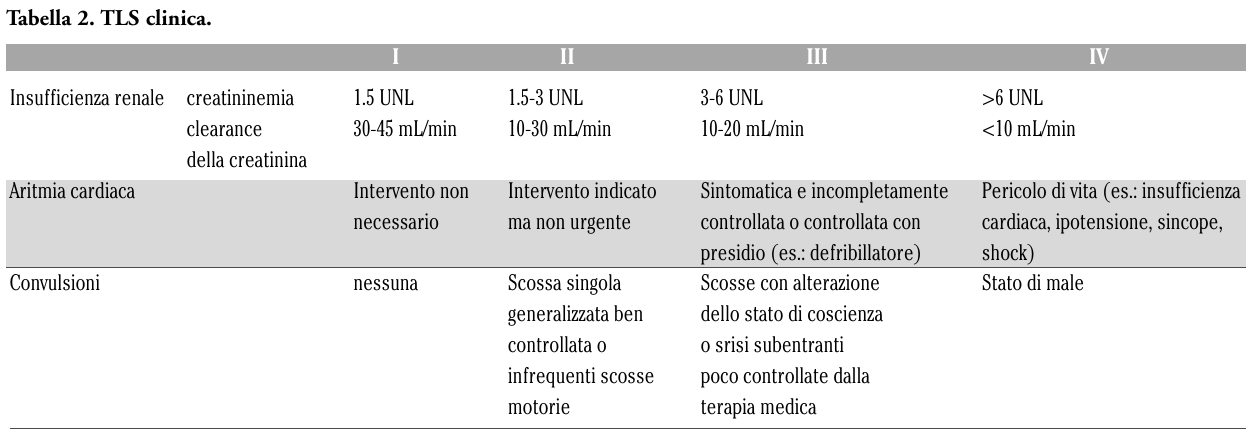
Tabella 2. TLS clinica.